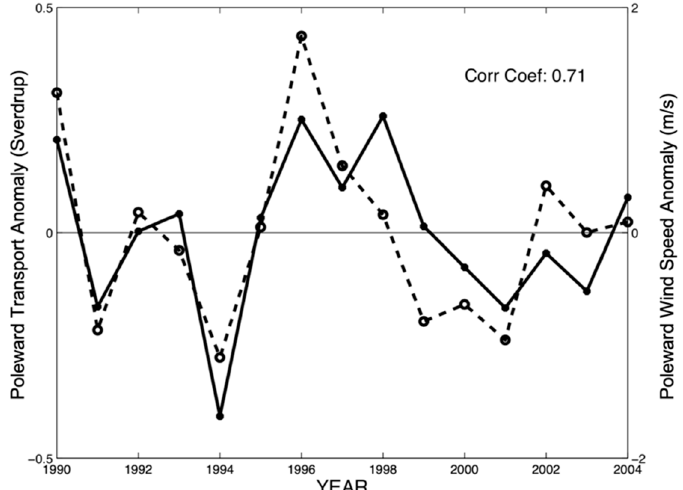
Figure 10. Correlation between the time series of the annual poleward transport anomaly (solid line, unit: Sverdrup) and poleward wind speed anomaly (dashed line, unit: m/s). The poleward transport data are from the ROMS solution and the poleward wind data are from the NCEP.